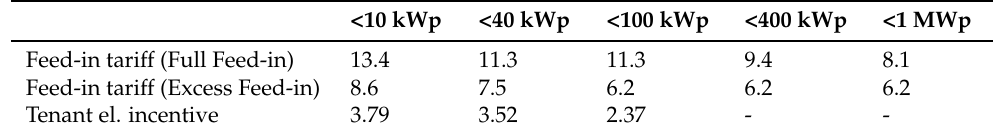
Table A2. Incentives [in ct/kWh]